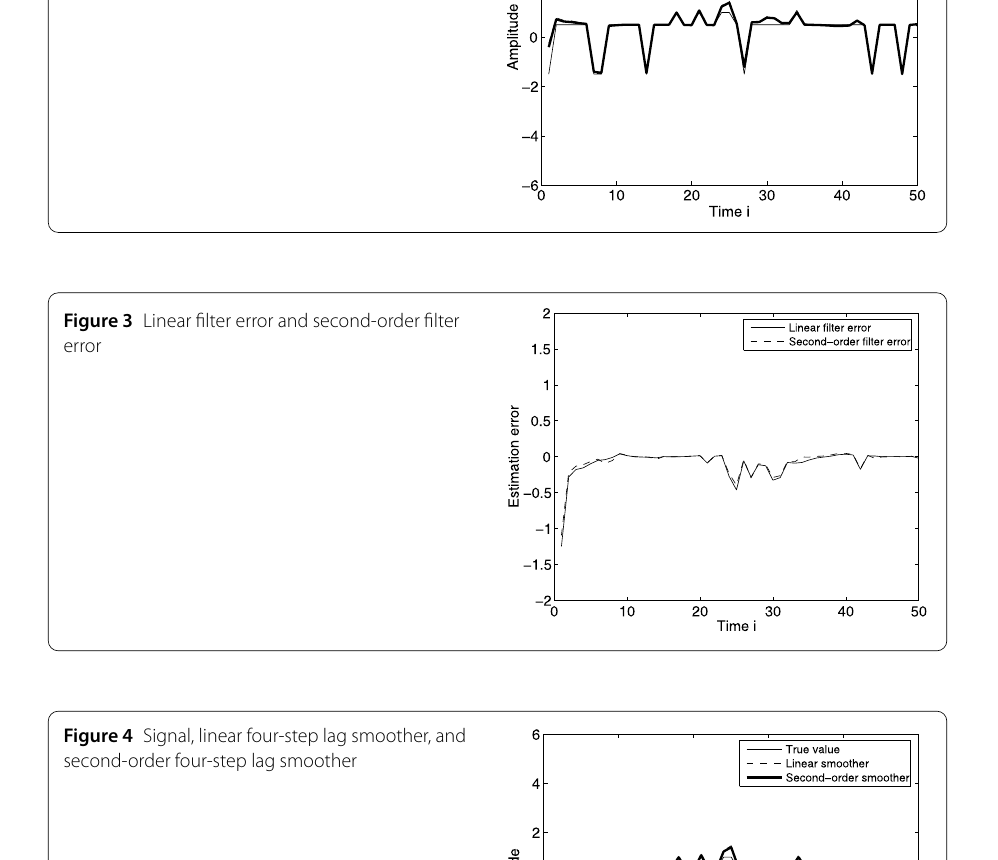
Figure 4 Signal, linear four-step lag smoother, and second-order four-step lag smoother